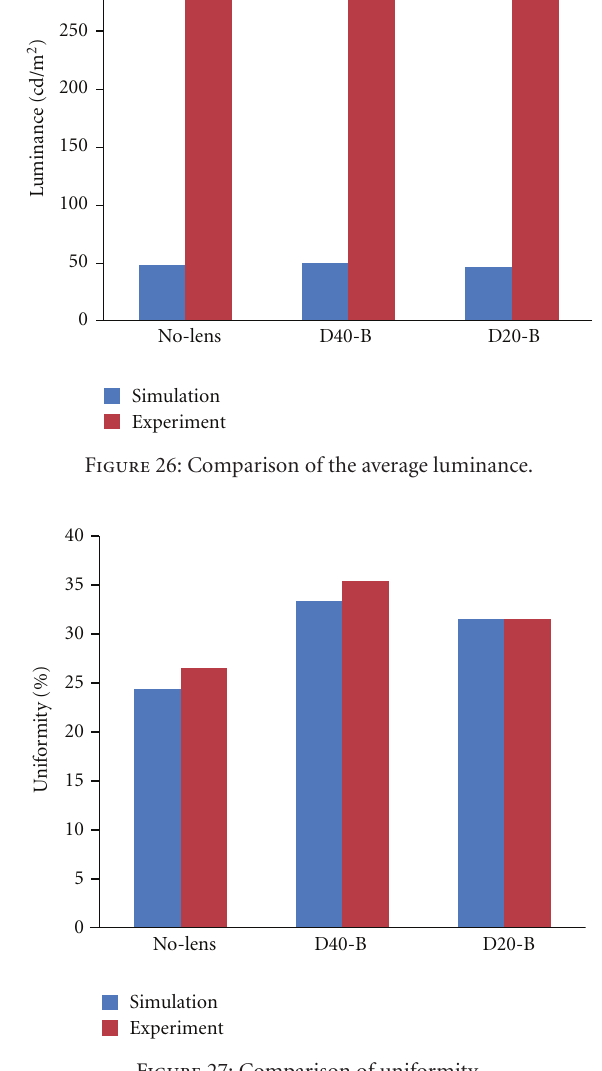
Figure 27: Comparison of